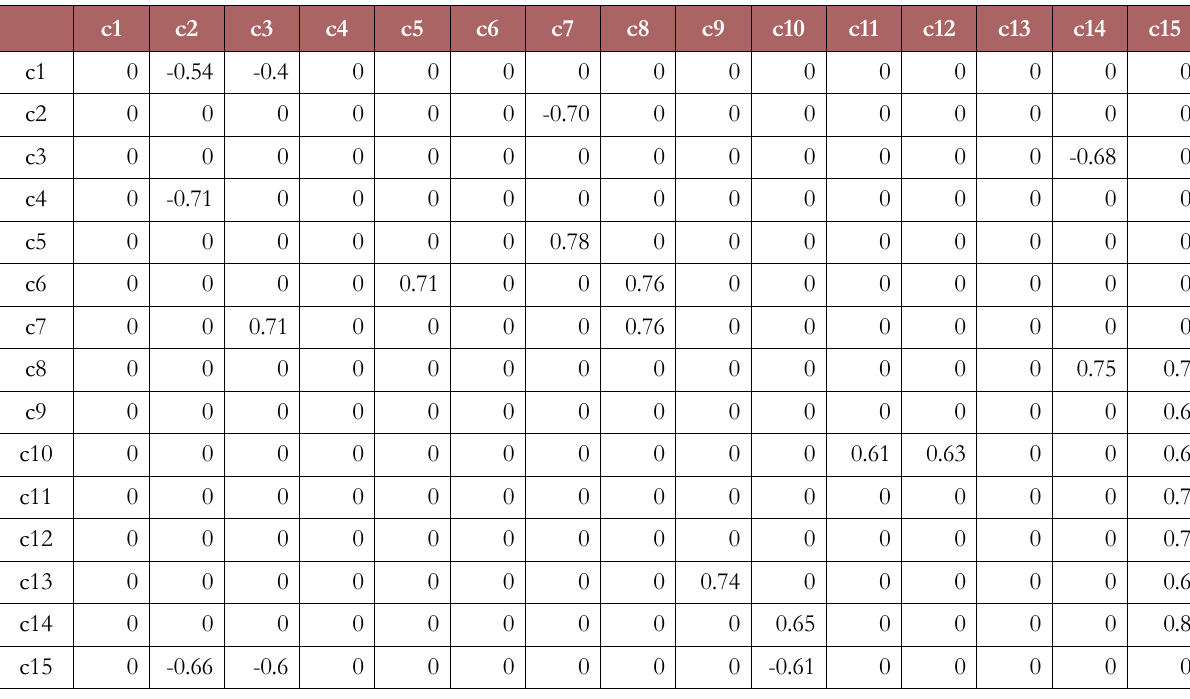
Table 7. The final matrix of success